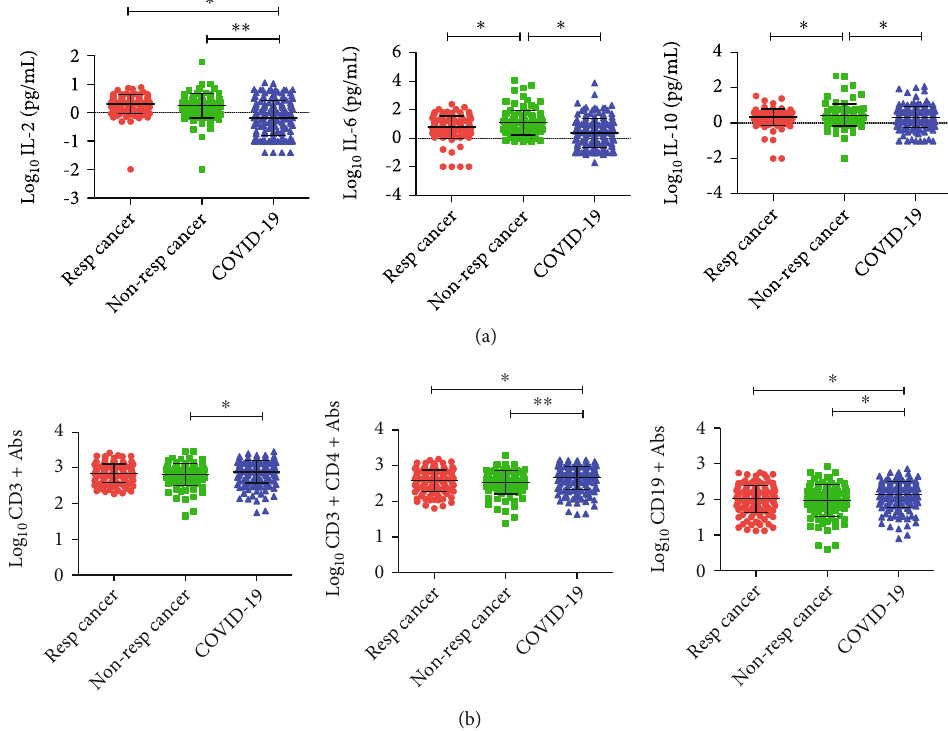
Figure 2: Analysis of immune cells and cytokines in three groups of patients with COVID-19 or cancer. Resp: respiratory cancer; Non-resp: nonrespiratory cancer. (a) IL-2 (left), IL-6 (middle), and IL-10 (right). (b) CD3 + Abs (left), CD3 + CD4 + Abs (middle), and CD19 + Abs